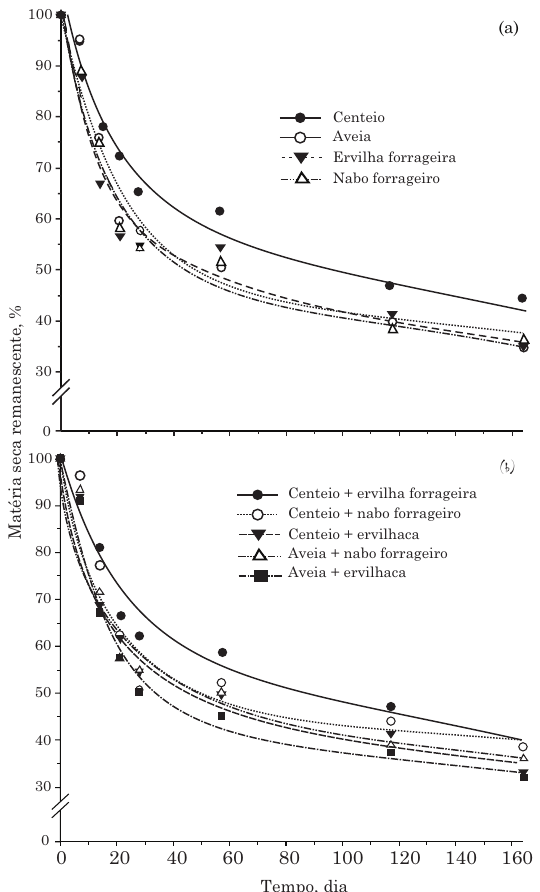
Figura 2. Matéria seca remanescente dos resíduos culturais de plantas de cobertura em cultura pura (a) e em consórcio (b), em avaliações realizadas em campo até 164 dias após a distribuição das sacolas de decomposição na superfície do solo.